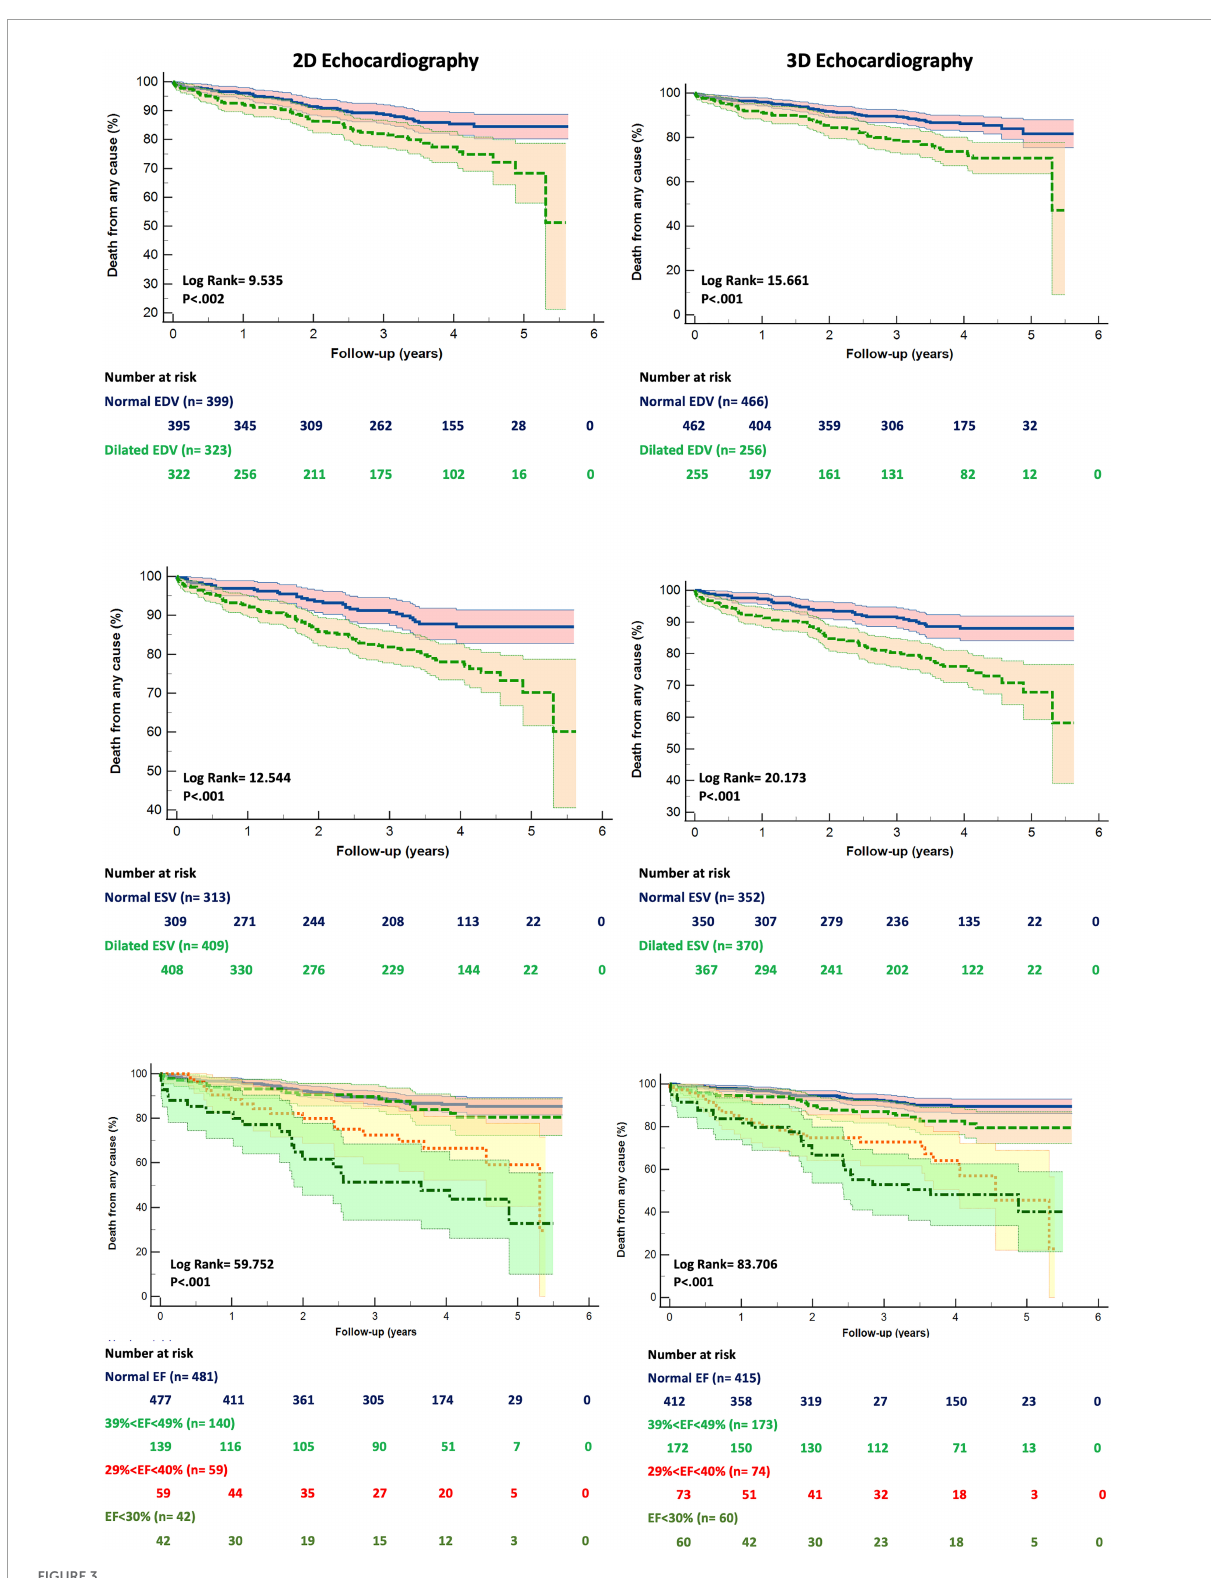
FIGURE3 Kaplan Meyers survival curves for dilated left ventricular end-diastolic (upper panels) , end-systolic (mid panels) volumes and reduced ejection fraction (bottom panels) obtained by two- (left panels) and three-dimensional (right panels) echocardiography, respectively. Abbreviations as in Figure 1